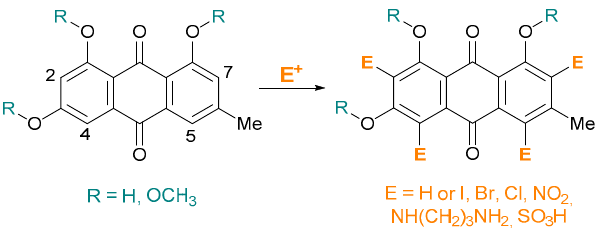
Figure 1. Derivatization of emodin.